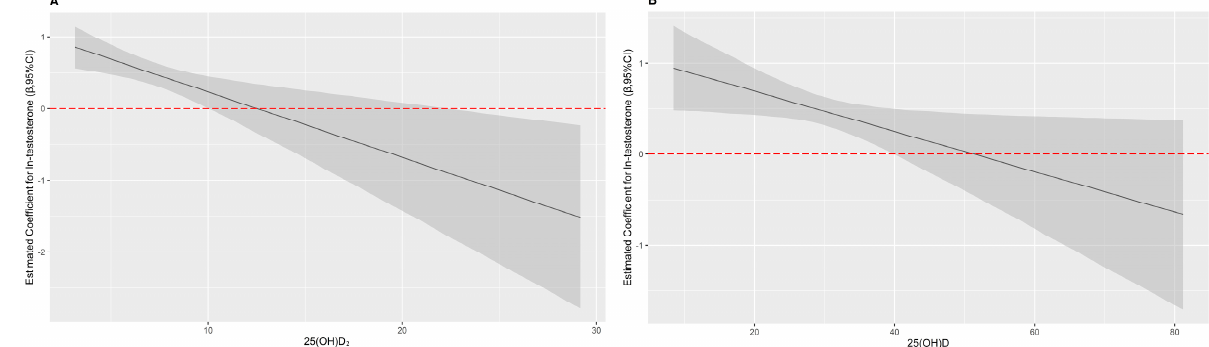
Figure 3. The interaction plots of 25(OH)D 2 , total 25(OH)D and testosterone on T2DM in females. ( A ) the effect of ln-testosterone on T2DM at different levels of 25(OH)D 2 ; ( B ) the effect of ln-testosterone on T2DM at different levels of total 25(OH)D; adjusted for smoking status, alcohol intake, physical activity, average monthly individual income, level of education, BMI, SBP, PP, TC, TG, HDL-C, LDL-C and a family history of T2DM.